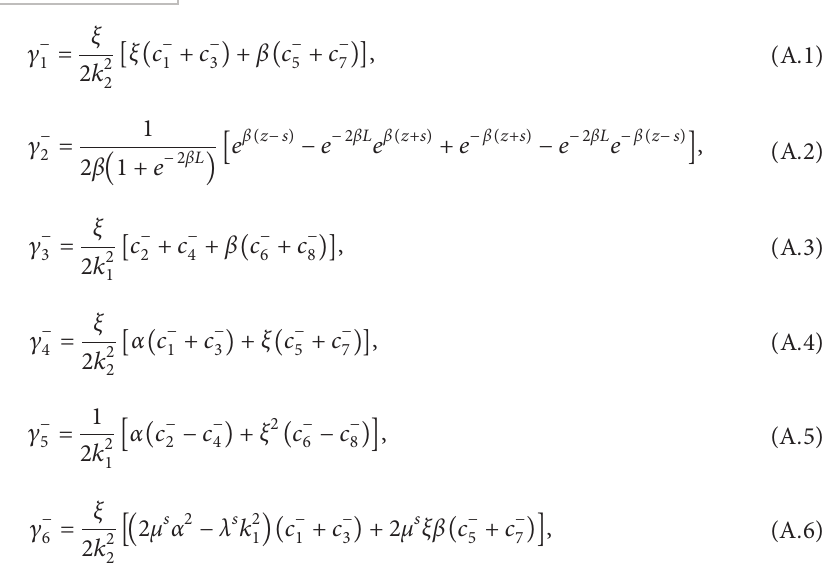
Figure 11: Lateral displacement u displacement; (b) imaginary part of lateral